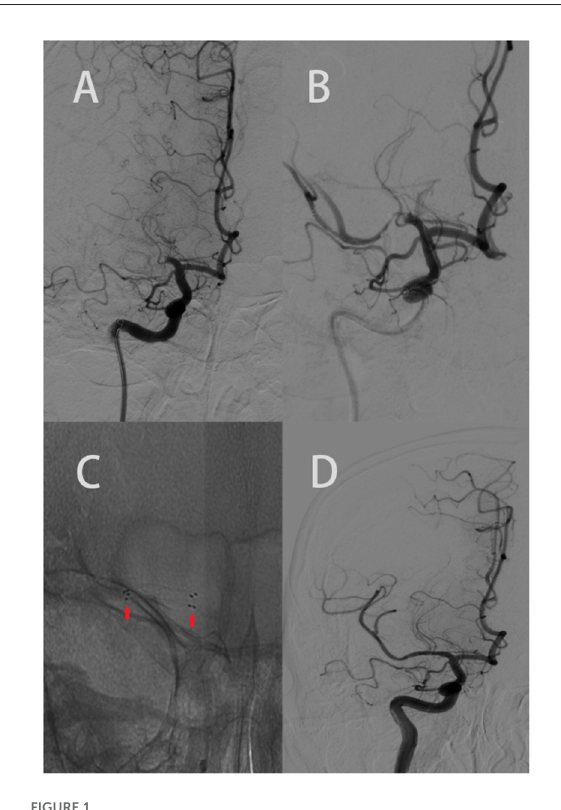
FIGURE1 Elderly patient with an acute onset of left body weakness, numbness, and difficulty speaking (NIHSS 7). The ASPECTS was 9 based on CT scan. (A) AP right carotid angiogram clearly showed an occlusion of the M1 segment of the right MCA. (B) Revealed the post failed MT with stenosis. (C) The red arrow shows the proximal and distal legs of the stent. (D) AP right carotid angiogram depicting recanalization of the right MCA and its branches (mTICI 3).